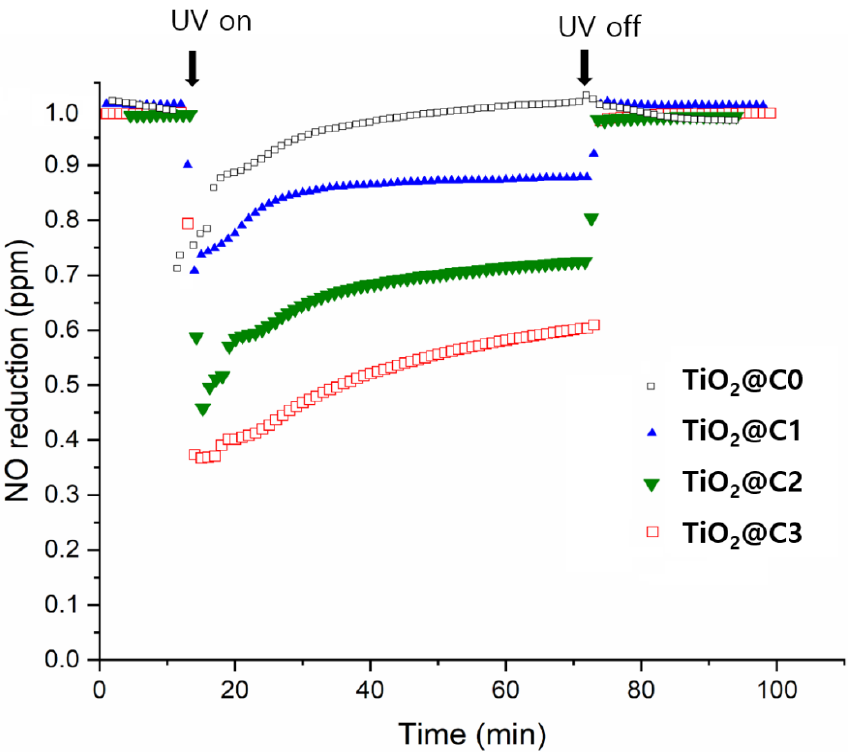
Figure 6. Photocatalytic performance of TiO 2 @C1, TiO 2 @C2, TiO 2 @C3, and TiO 2 @C4 for NO